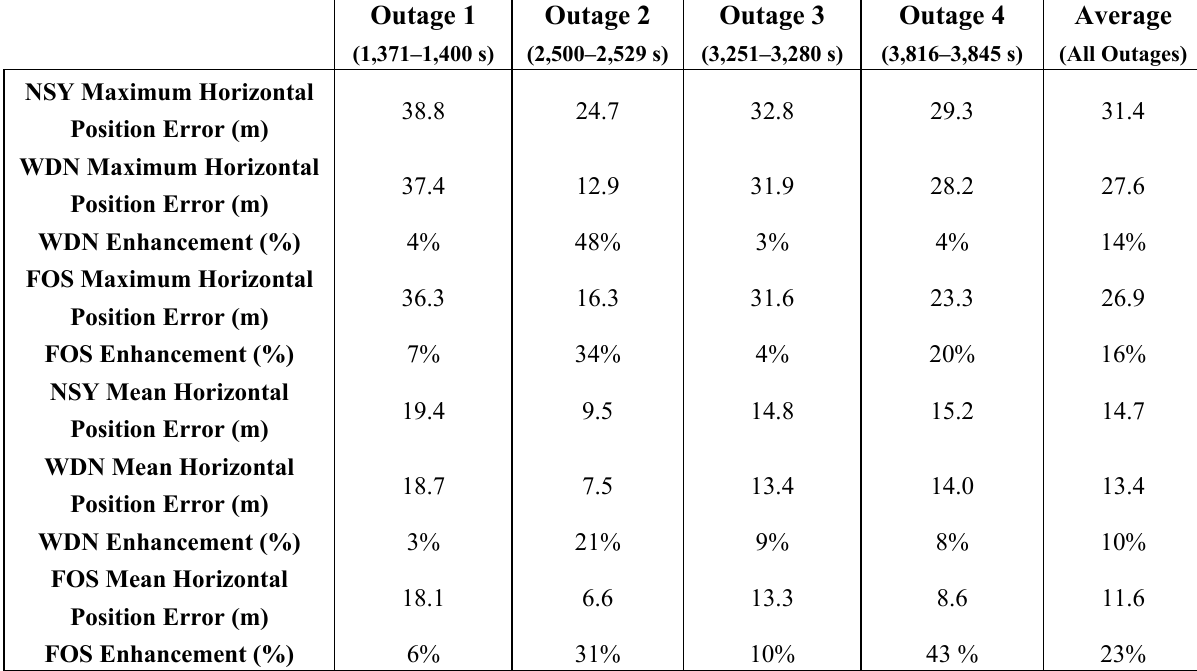
Table 5. Summary of position domain accuracy enhancement during GPS outages (Road Test